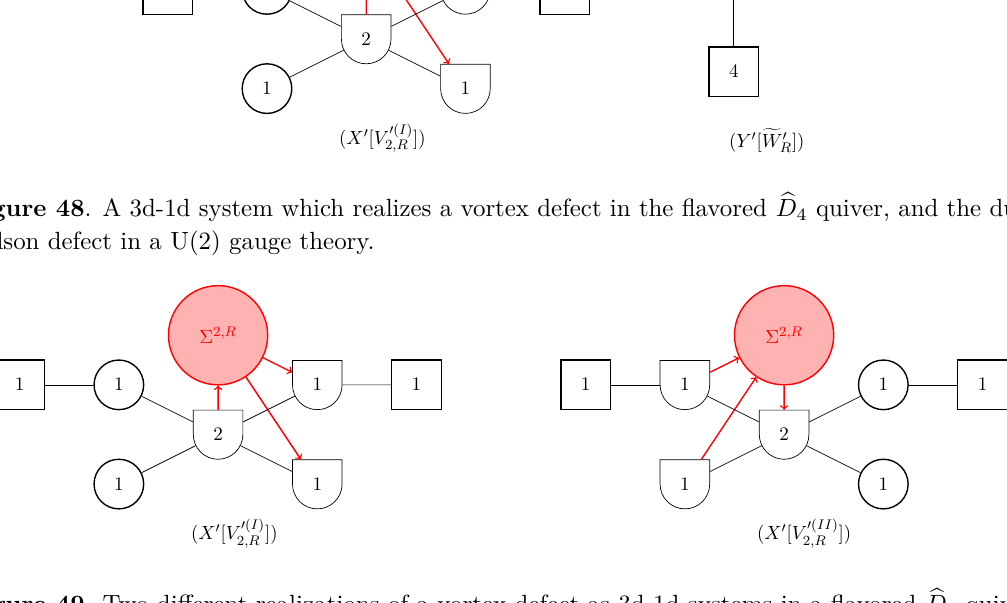
Figure 49 . Two different realizations of a vortex defect as 3d-1d systems in a flavored b D 4 quiver, dual to a Wilson defect in the U(2) gauge theory of figure 48. The Witten index for the SQM in the first case should be computed in the chamber ξ < 0 , while for the second case it should be computed in ξ > 0